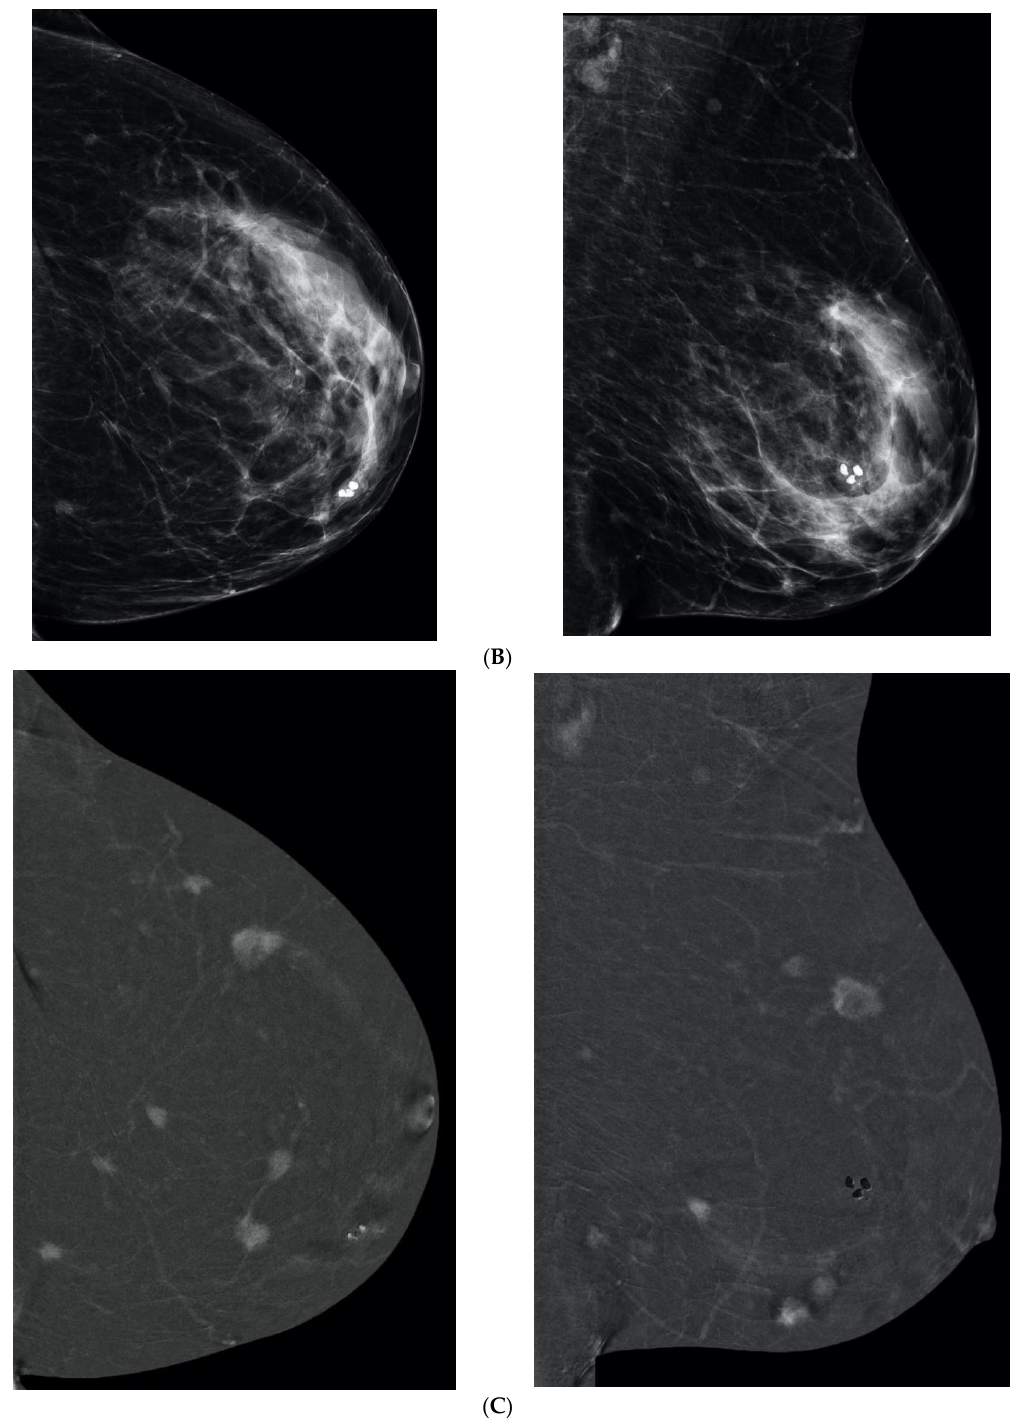
Figure 8. Courtesy of Dr. Anat Kornecki. This 71-year-old woman with BI-RADS C density was recalled from screening because of architectural distortion in the left upper outer quadrant. ( A ) Screening CC and MLO views, with area of distortion circled. ( B ) low-energy CC and MLO views. High-energy views not shown. ( C ) subtraction CC and MLO views, showing multiple areas of enhancement. Note that 5 lesions are in the medial breast, which was not dense mammographically. The two lesions furthest apart were core biopsied, and both confirmed malignant. Mastectomy was performed, and showed 5 foci of invasive lobular